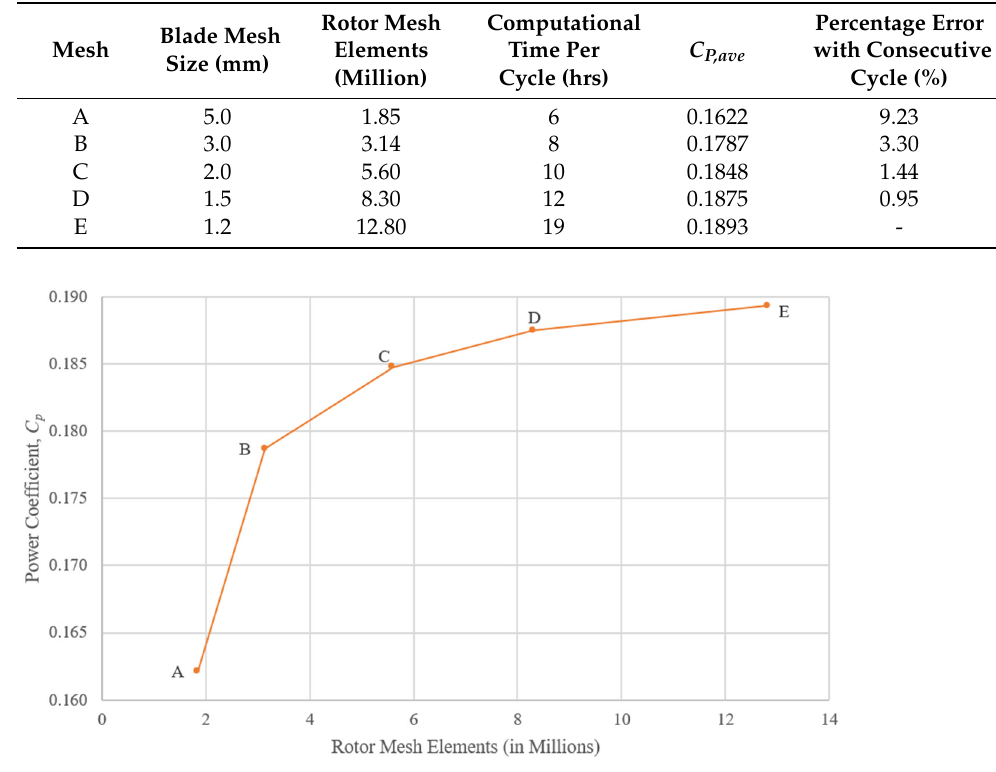
Figure 6. Cycle-averaged C P at TSR 2 for different blade mesh sizes.